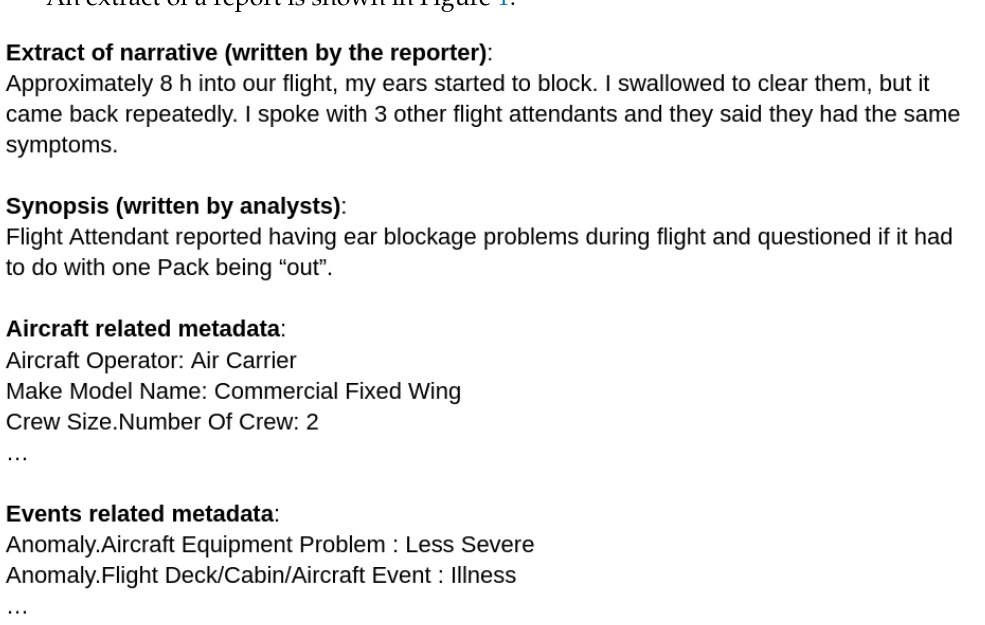
Figure 1. Extract of an occurrence